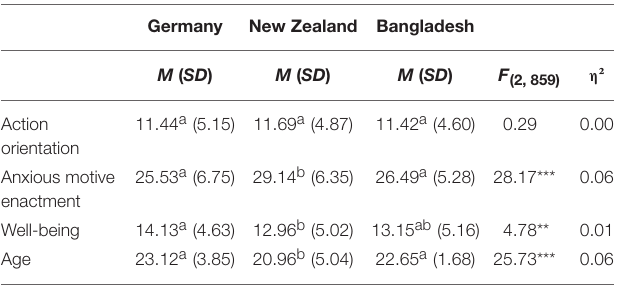
TABLE 1 | Descriptive Statistics of Main Study Variables for the Three Sample Groups.